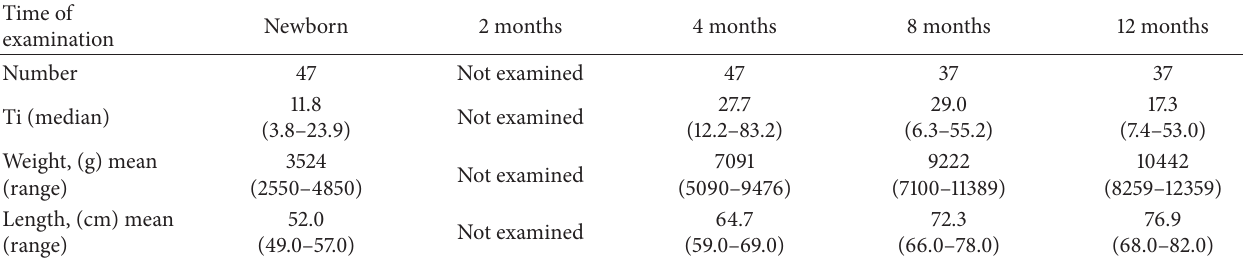
Table 2: The term HIV-unexposed infants: the number of infants, the thymic size (Ti), and the weight and length at the times of assessment. Time of